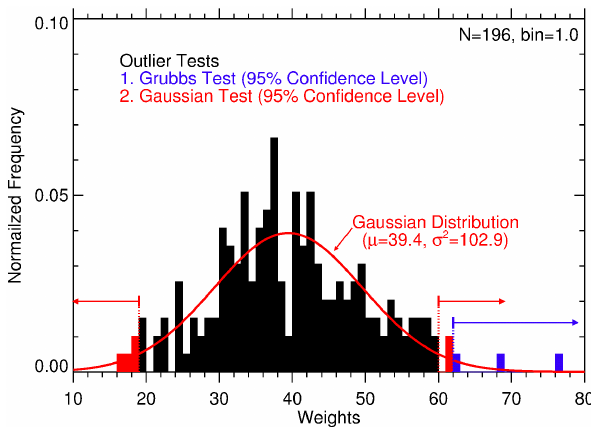
Figure 7. An example of outlier tests (Grubbs and Gaussian tests) within a 95% confidence level using monthly AERONET data at GSFC from 1993 to 2009. The frequency of weights is normalized to total number ( N ). In this case, 9 outliers are filtered out and 187 significant weighting factors remain after the outlier